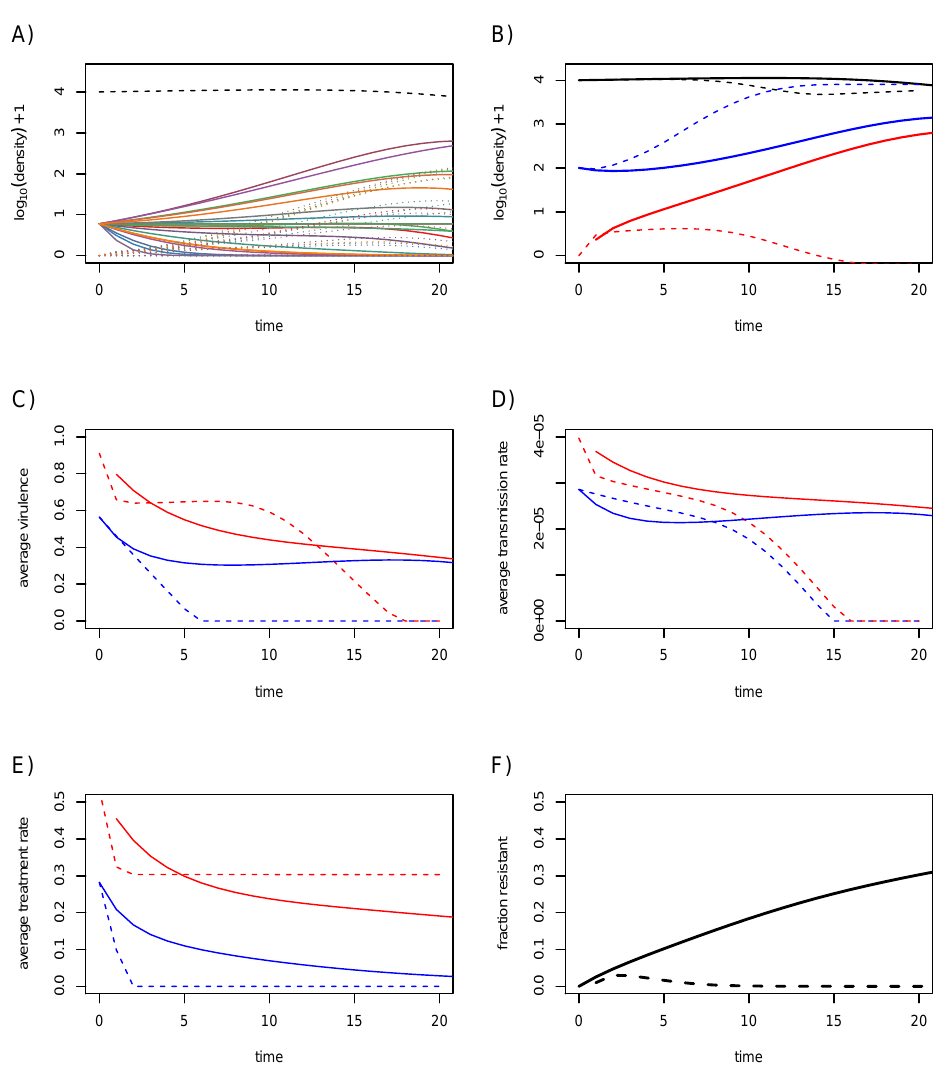
Figure 2 – Short term evolutionary dynamics. A) Dynamics of the densities of susceptible hosts (dashed black line), of drug-susceptible infections (plain coloured lines) and drug-resistant infections (dotted coloured line). Each colour corresponds to one of the n = 20 strains. B) Same as A but the blue line shows the total density of drug-susceptible infections and the red line the total density of drug-resistant infections. The dashed lines are the predictions from the Price equation system. C) Average virulence in the drug-sensitive (blue) and drug-resistant infections (red) for numerical multi-strain simulations (plain line) and the Price equation system (dashed line). D) Same as panel C for transmission rate. E) Same as panel C for treatment rate. F) Fraction of the infections that are drug-resistant in the multi-strain simulation (plain line) or using the Price equation (dashed line). We assume no fitness cost ( a = b = 1 ) and a transmission-virulence trade-off ( β ( α ) = 10 − 4 √ α ). Other parameter values are λ = 0.02 , µ = 4.5 10 − 5 , ν = 0 , a = b = 1 , ρ = 0.1 , Cov ( α , γ ) = 0.1 , Var ( γ ) = 1 / 12 , × Var ( α ) = 1 / 6 , α (0) = 1 / 2 , γ (0) = 1 / 4 , S (0) = 10 4 , I i = 5 , and I R i = 0 . The default time unit is the week (but it can be rescaled without affecting the results